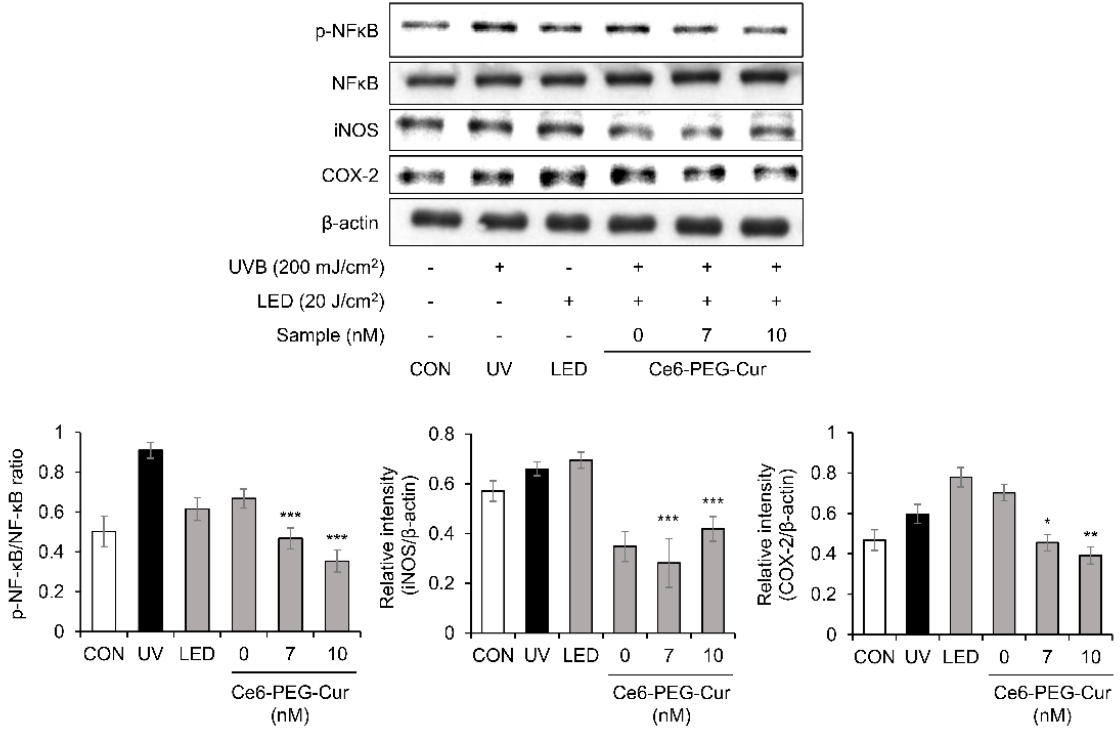
Figure 4. Inhibition of UVB-induced expression of p-NF- κ B, iNOS and COX-2 by Ce6-PEG-curcumin- mediated PDT. Results are expressed as mean ± SD. * p < 0.05, ** p < 0.01 and *** p < 0.001 vs. UVB-irradiated control.